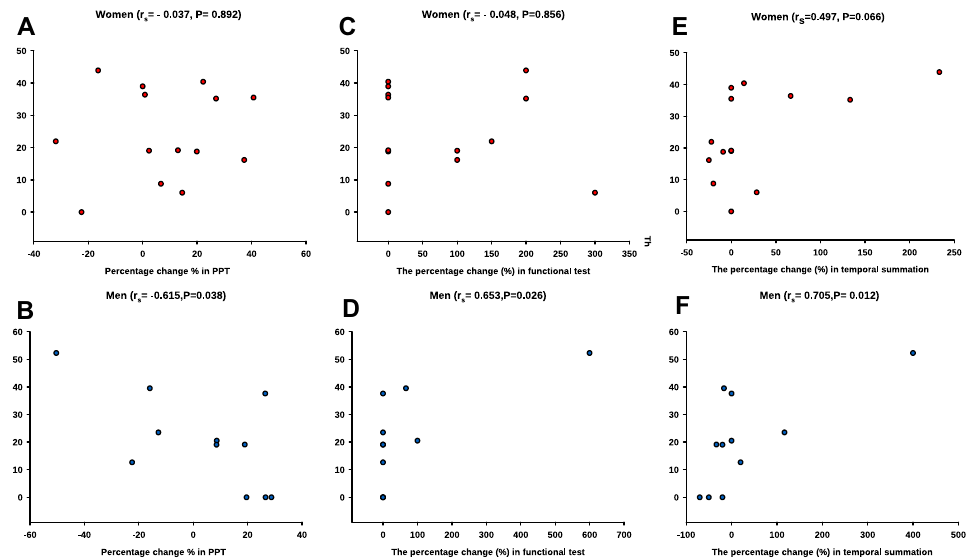
Figure 5. Graphs illustrating the correlations between the level of sensitization and frequency of nerve fibers co-expressing substance P and NMDA-receptor 2B within connective tissue . The correlation between the percentage change of pressure pain threshold (PPT), chewing pain and temporal summation pain (from baseline to 5 min after glutamate injection) and the frequency of nerve-fibers co-expressing substance P and NMDA-receptor 2B on day 0 in 15 healthy women and 15 age-matched men. ( A , B ) PPT in women and men, respectively. ( C , D ) Chewing pain (functional test) in women and men, respectively. ( E , F ) temporal summation pain in women and men,